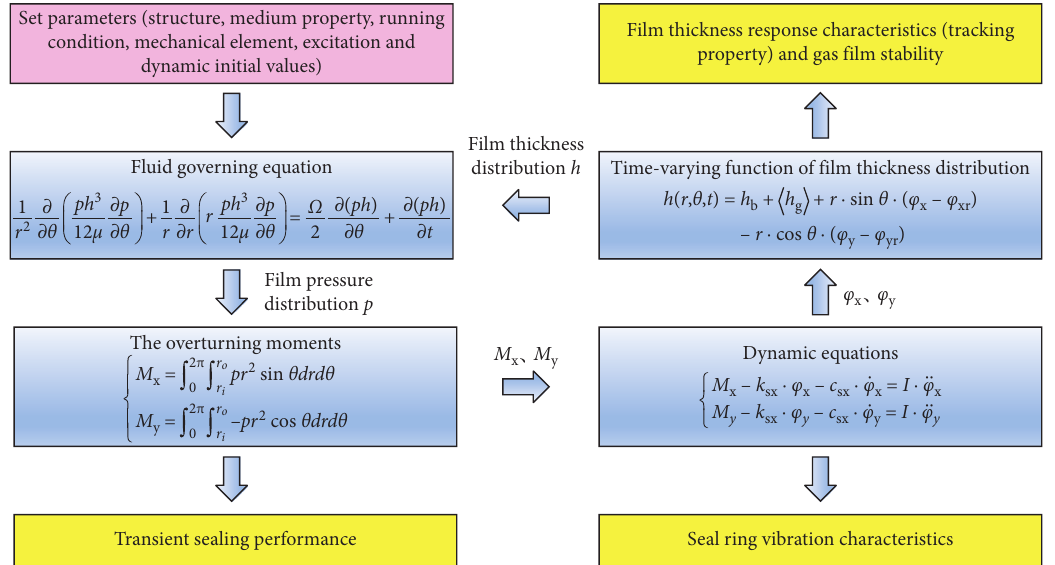
Figure 6: Calculation process of the direct numerical simulation method.